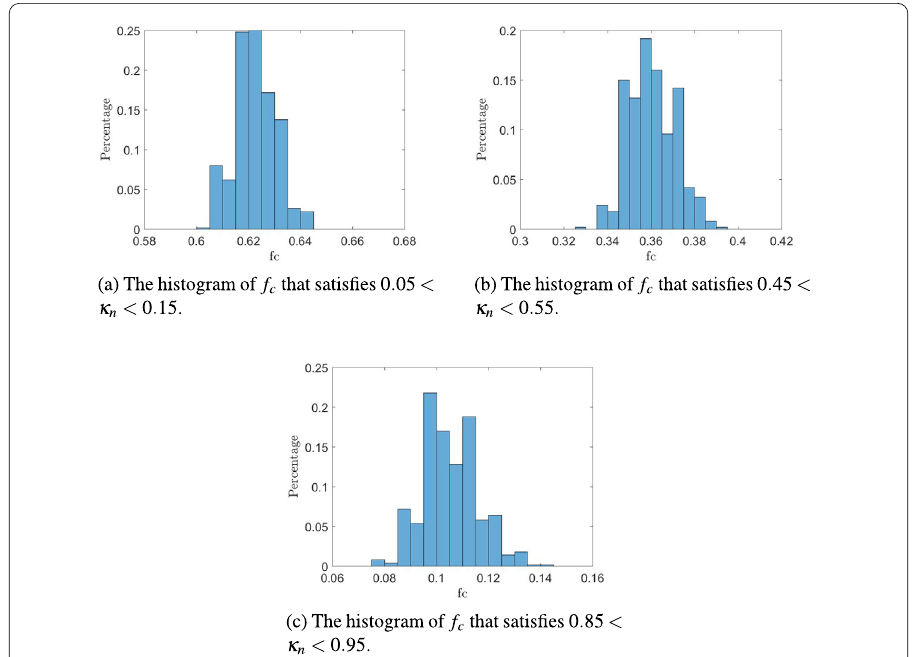
Figure 5 The histograms of the fraction of closed channels f c for the triangular network